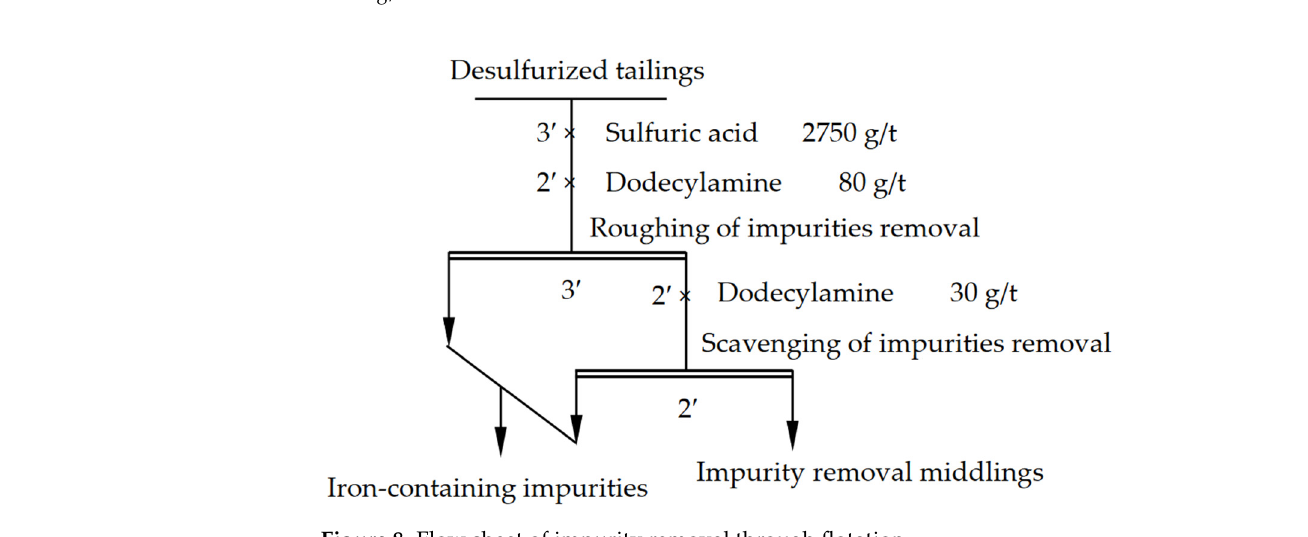
Figure 8. Flow sheet of impurity removal through flotation. Table 9. Result of impurity removal (mass fraction,